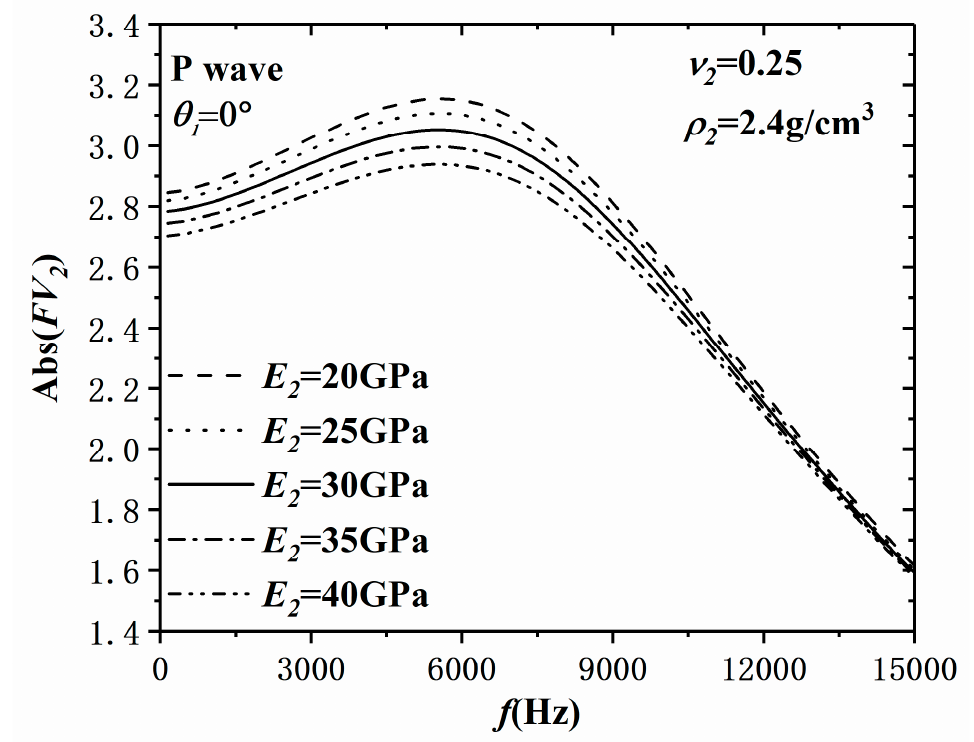
Figure 3. Influence of Young’s modulus of the expansive grout on the theoretical amplitude spectrum of gauge combination FV 2 for the incident P wave. 171 Table 2. Influence of Young's modulus of the expansive grout on the theoretical amplitude spectrum 172 of gauge combinations FV 2 , FV 4 , FS, TV and TS for the incident P wave. 173